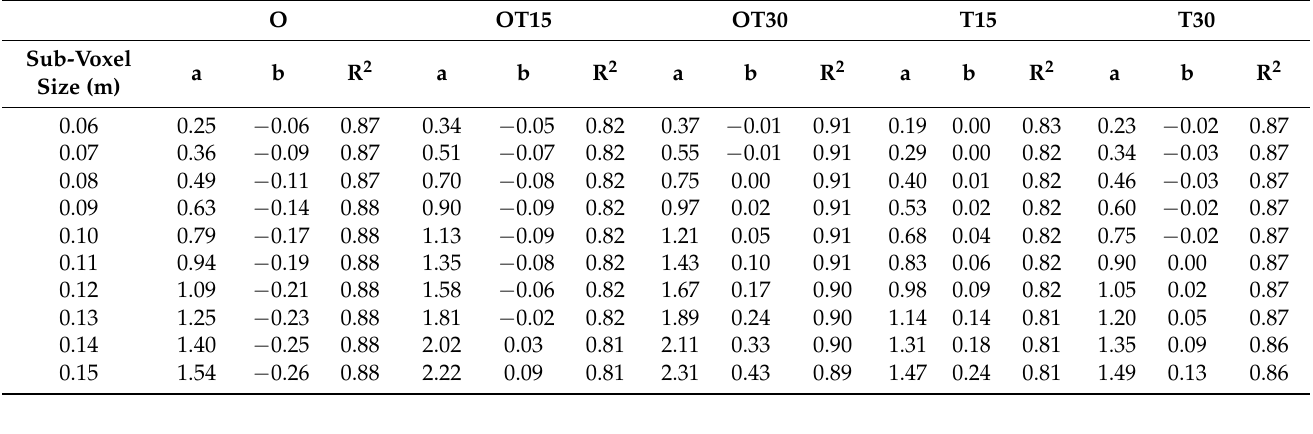
Table 1. Linear fitting results between the LAI derived from five schemes under different sub-voxel sizes and LAIe (a is slope, b is intercept and R 2 is the square of correlation coefficient).